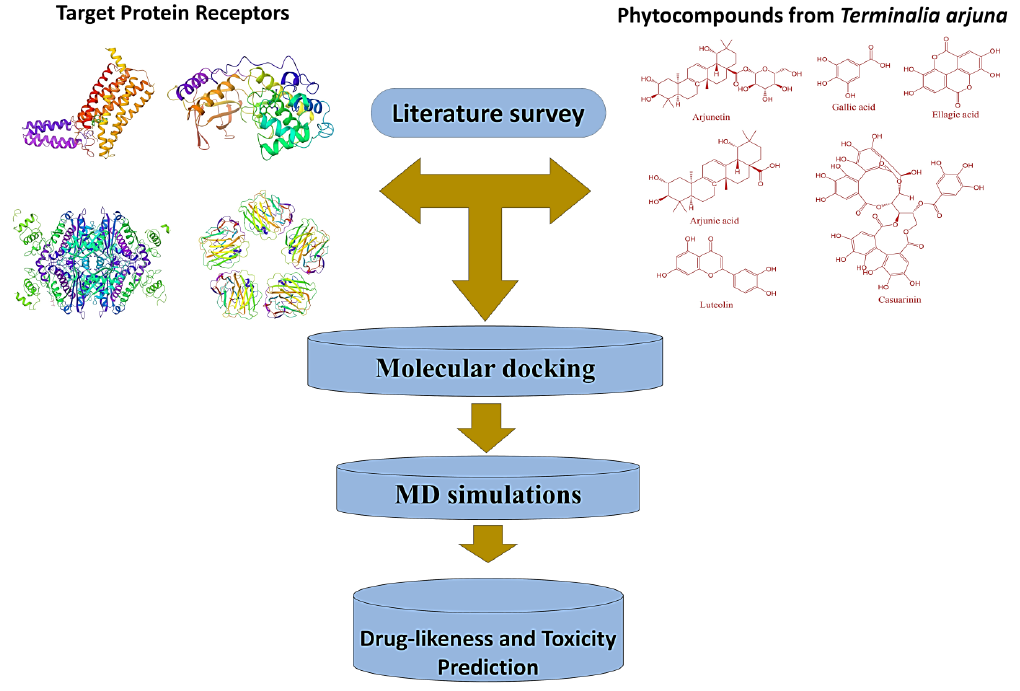
Figure 7. Workflow scheme adapted in the present